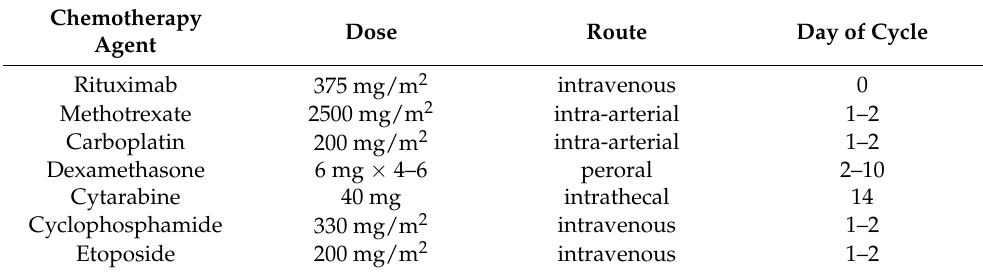
Table 1. Chemotherapeutic agents, doses, routes, and days of administration in the BBBD a